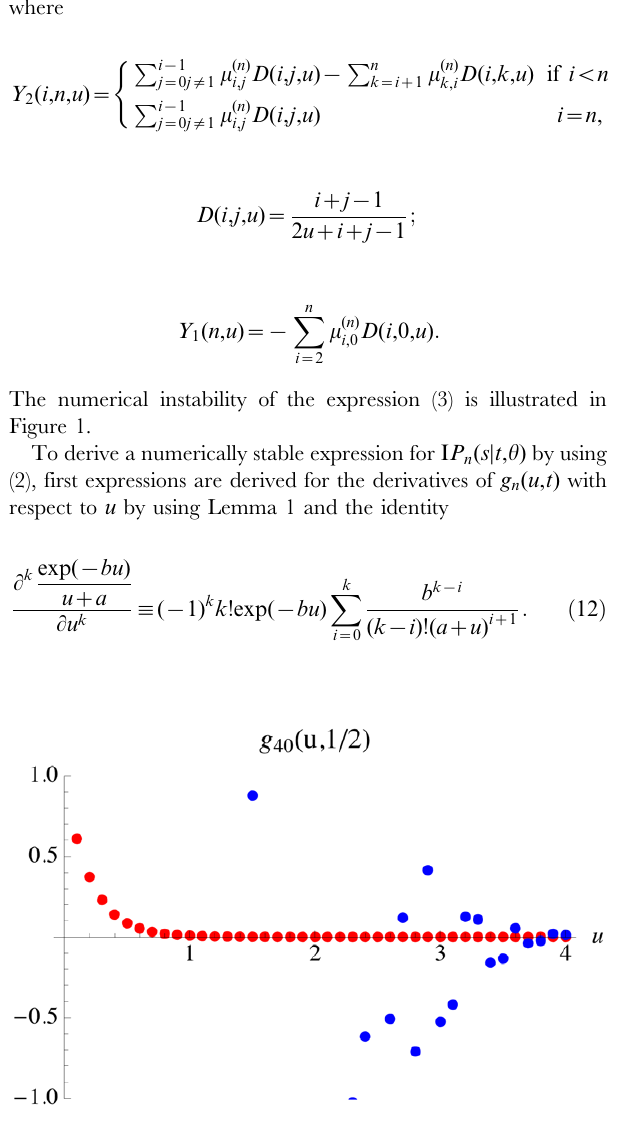
Figure 1. Illustration of numerical instability of the expression ,1 2) is plotted for the same (3). The moment generating function g 40 ( u range of values of u in red and blue dots by using the expressions (11) and (3), respectively. The numerical instability of the expression (3) is ,1 obvious because the values of g 40 ( u 2) must be between 0 and 1 for any positive u